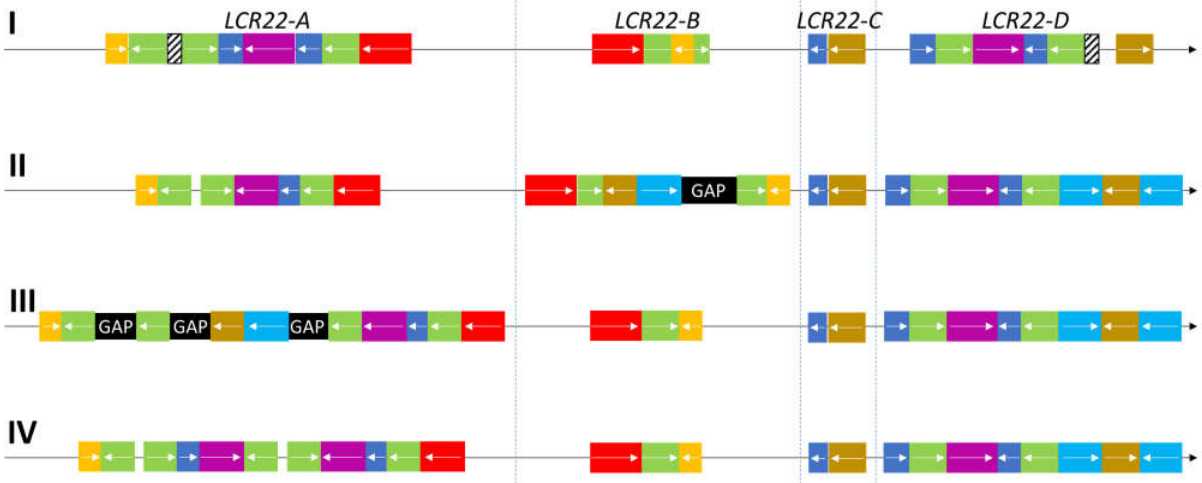
Figure 2. Organization of LCR22-duplicated modules in several references. (I) First description of the LCR22 structure in Shaikh et al. (2000). These modules serve as ‘essential duplicons’ in the comparison and composition of the LCR22s in the other reference genomes (II–IV). The yellow duplicon contains USP18 (or a paralogue). The red duplicon encompasses (paralogues of) the genes PRODH and DGCR6. The PI4KA gene or a paralogue is present in the mustard-colored blocks. The cyan duplicon always covers a RIMBP3 paralogue, the blue duplicon a BCR paralogue, and the magenta duplicon a GGT paralogue. A FAM230 paralogue can be found in the green duplicon, as well as a palindromic AT-rich repeat. (II) LCR22 organization in GRCh37/hg19. (III) LCR22 organization in GRCh38/hg38. (IV) LCR22 organization, for the first time without gaps, in the most recent reference genome (T2T-CHM13).